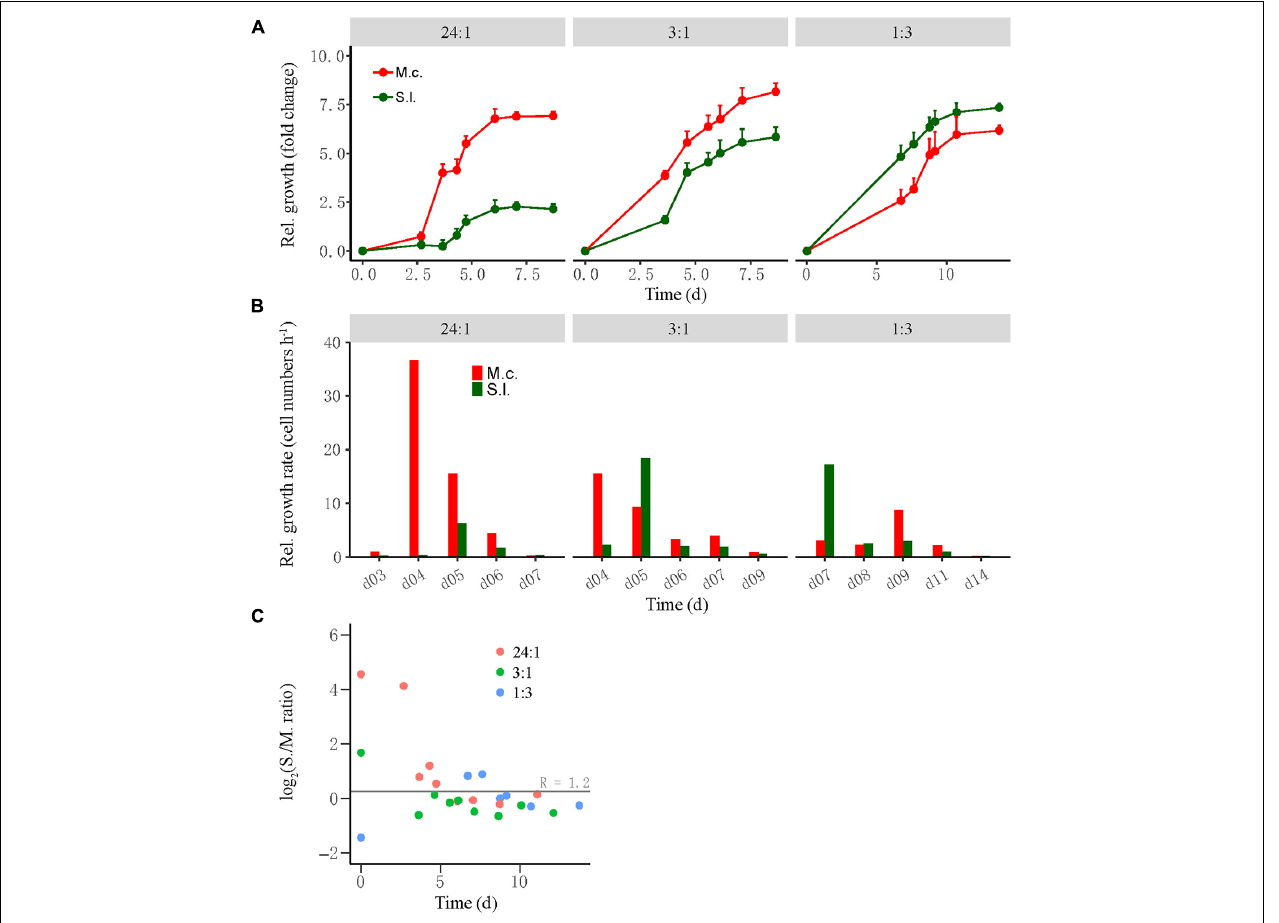
FIGURE 2 | The growth synchronization of Syntrophothermus lipocalidus (S.l.) and Methanocella conradii (M.c.) in the thermophilic coculture. The relative growth (A) of the individual populations was estimated as the fold change of cell number at any timepoint relative to that at the beginning, while the relative growth rate (B) was defined as the difference in cell number between two timepoints divided by the duration. Note that the change in Syntrophothermus – Methanocella cell ratio over time (C) is shown in logarithmic scale. The error bars in (A) indicate the positive values of standard deviation of four